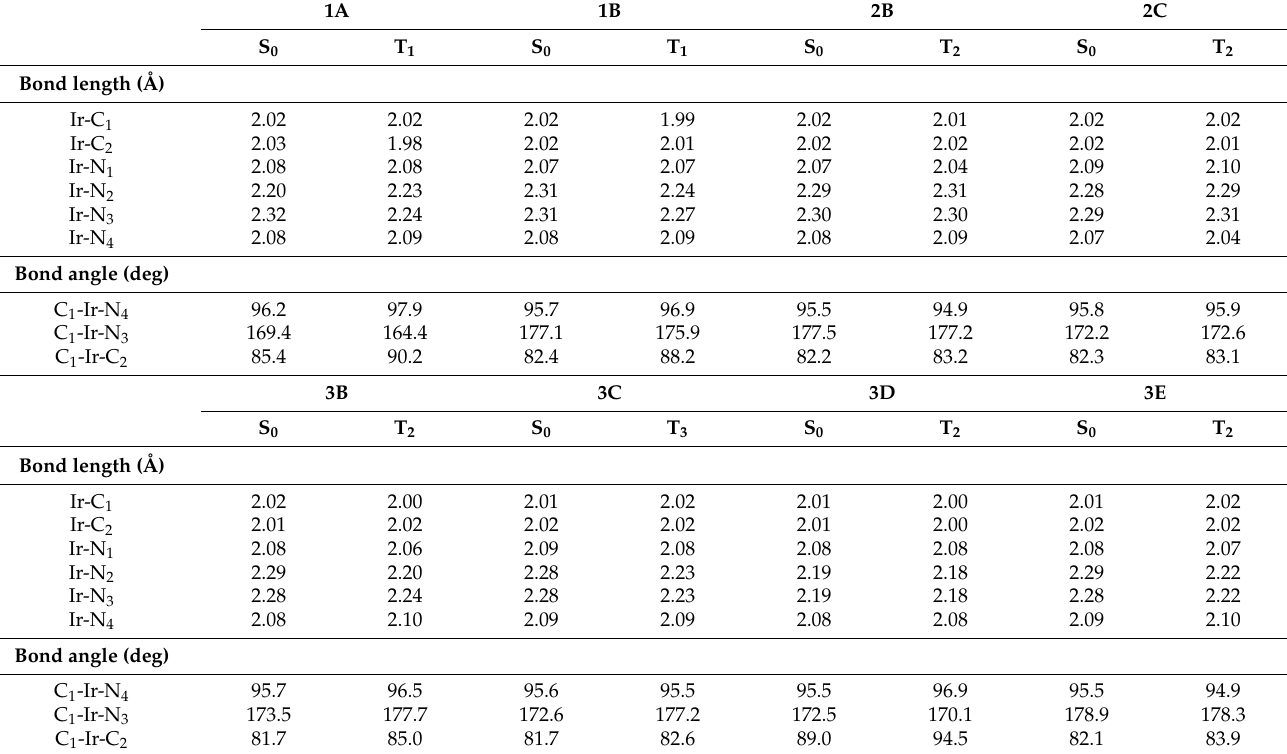
Table 1. Selected optimized geometric parameters of all complexes under study in the S 0 and